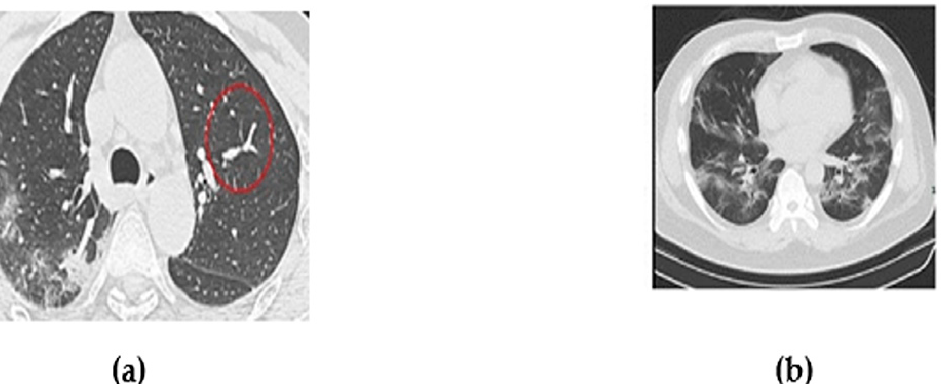
Figure 2. Sample CT scan images of 2 COVID-19 patients ( a ) COVID-19 infected ( b ) normal CT scan